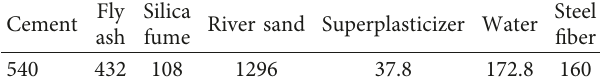
Table 1: Mixture proportion of UHPC (kg/m 3